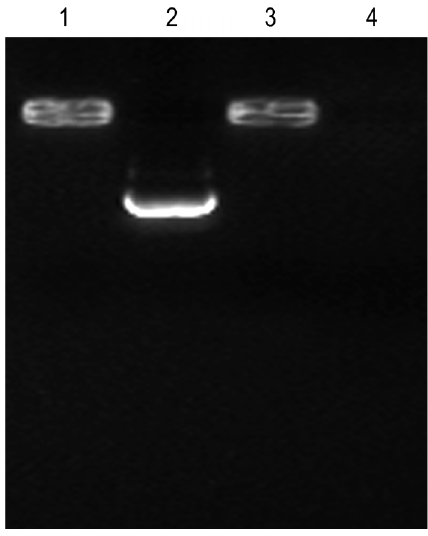
Figure 2. Degradation of the chitosan-DNA nanoparticles by DNase I. The chitosan-DNA nanoparticles and naked DNA plasmids were all digested with or without DNase I (RNase free, 40 U/ m L) at 37 6 C for 30 min. The resulting products were analyzed by agarose gel electrophoresis. Lane 1 , chitosan-DNA nanopar- ticles were digested without DNase I; lane 2 , naked DNA plasmids were digested without DNase I; lane 3 , chitosan-DNA nanoparti- cles were digested by DNase I; lane 4 , naked DNA plasmids were digested by DNase